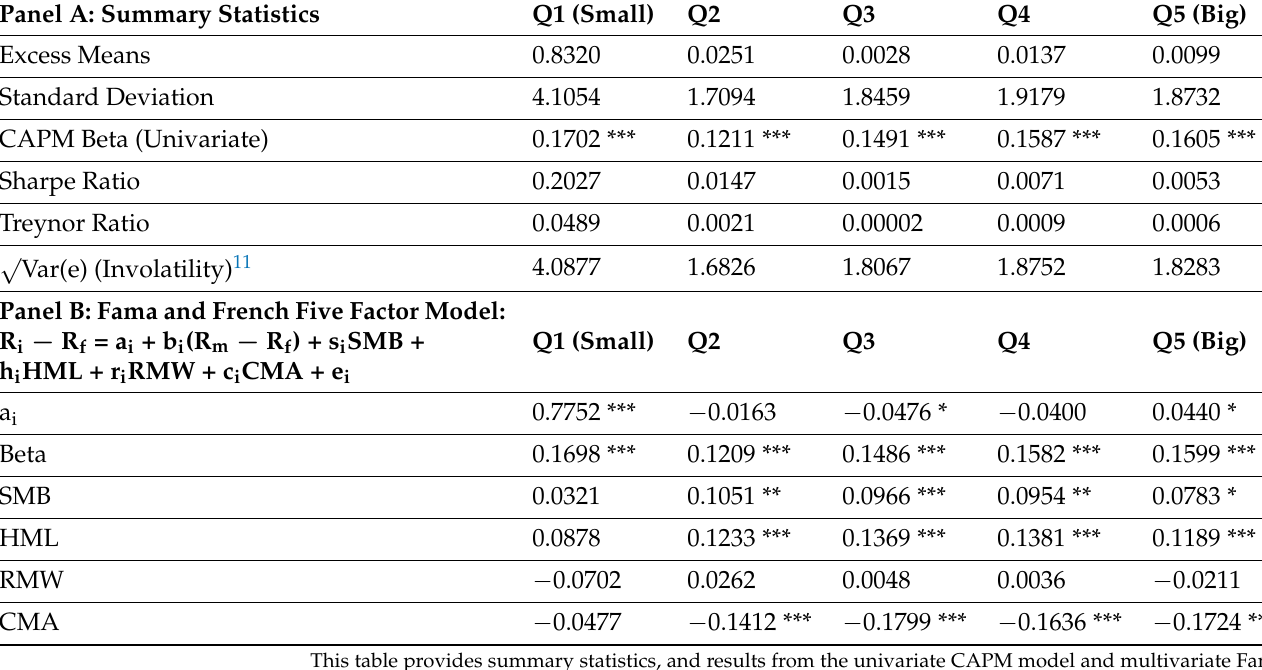
Table 2. Risk measures for Small and Big REIT portfolios (2001–2020).